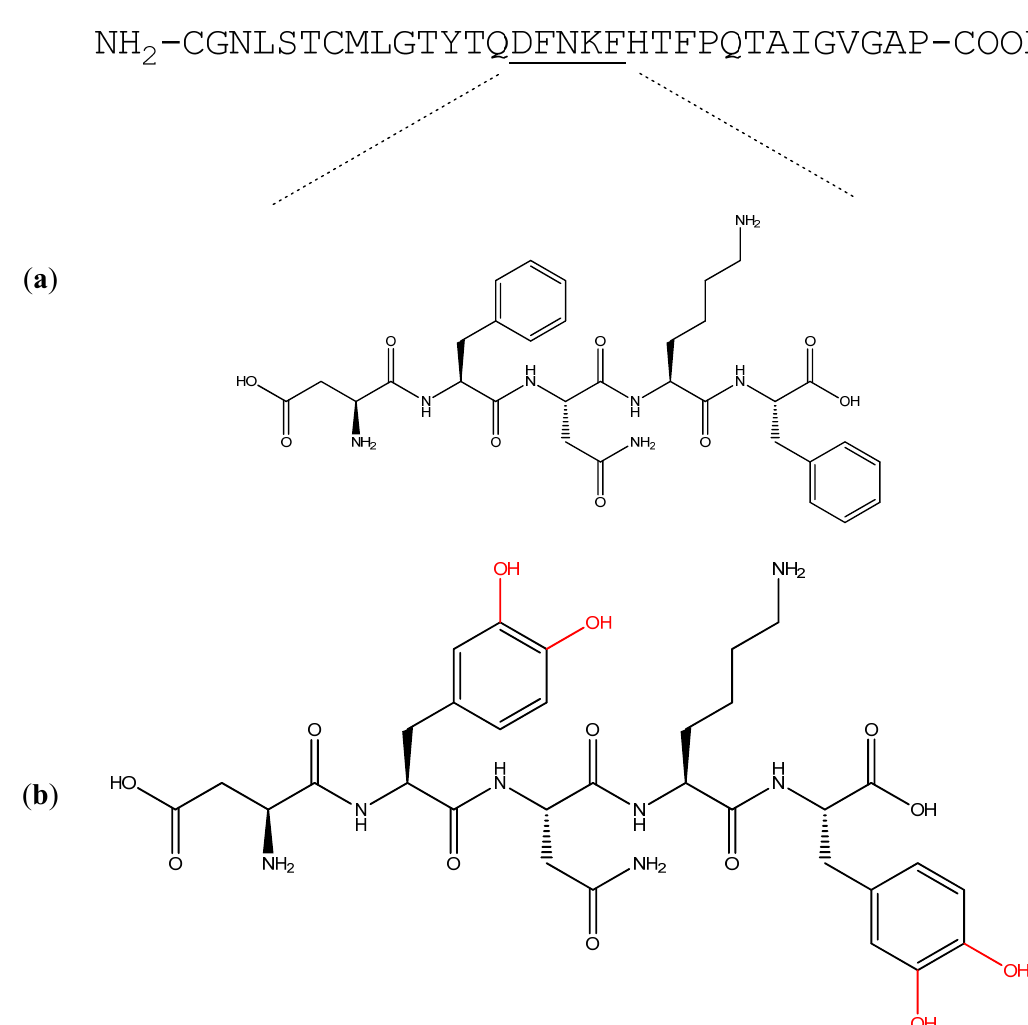
Figure 1. A L-3,4-dihydroxyphenylalanine (DOPA)-containing building block inspired